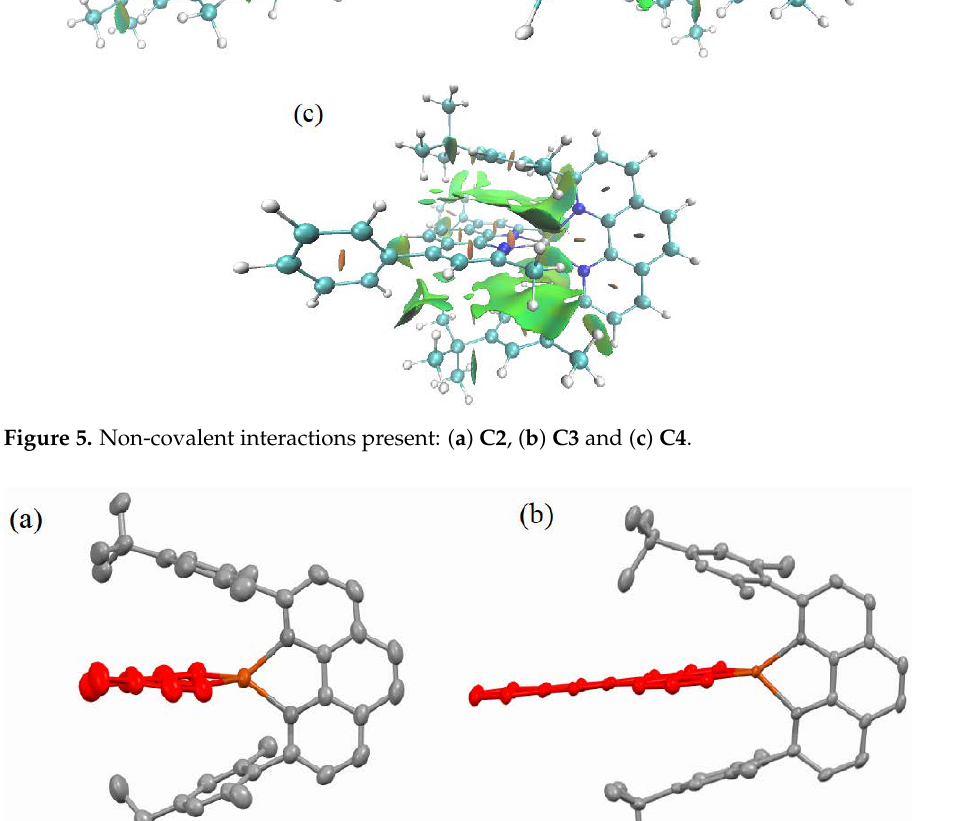
Figure 5. Non-covalent interactions present: ( a ) C2 , ( b ) C3 and ( c ) C4 .